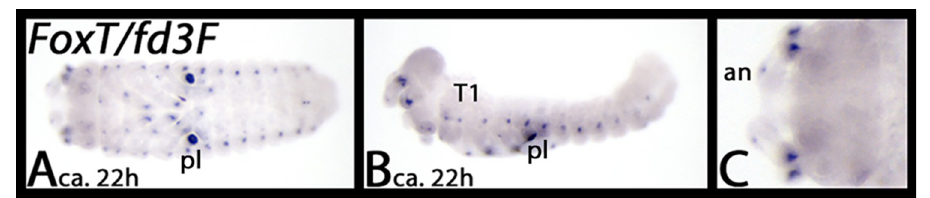
Fig 21. Expression of Tribolium fd3F . Panel A ventral view, panel B lateral view and panel C close-up on head, dorsal view. Note the unspecific staining in the pleuropodia in panels A and B. Abbreviations in Table 2.